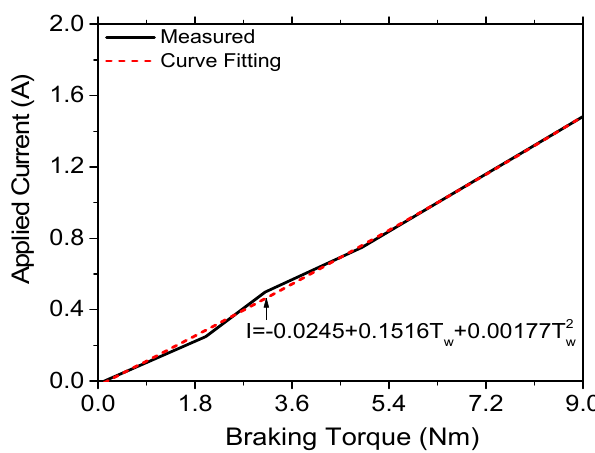
Figure 18. Applied current of the waist MR brake as a function of torque.